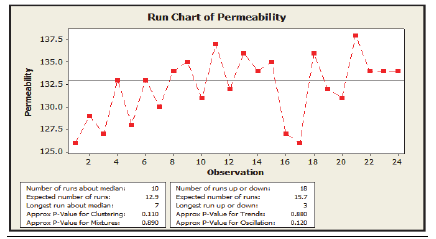
Fig. 12. Anderson – Darling Normality Test for Sand Permeability